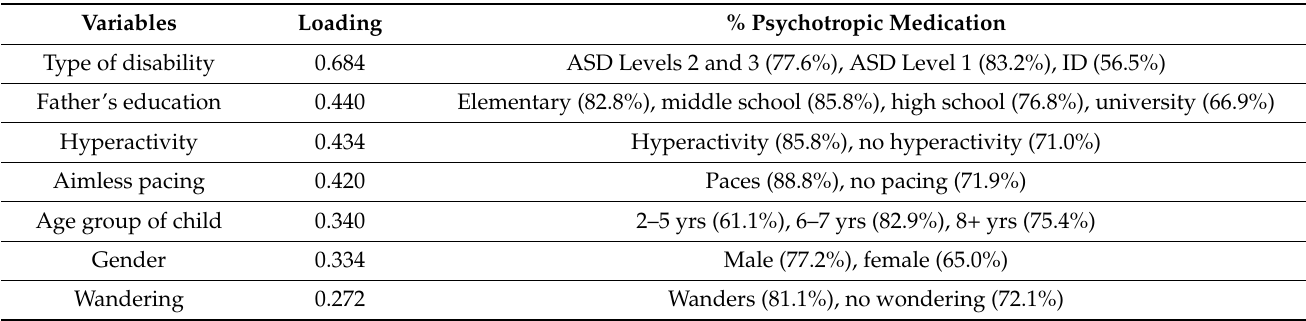
Table 3. The structure matrix of variables that best discriminated between children receiving psychotropic medication and the percentages within the subgroupings of the predictor